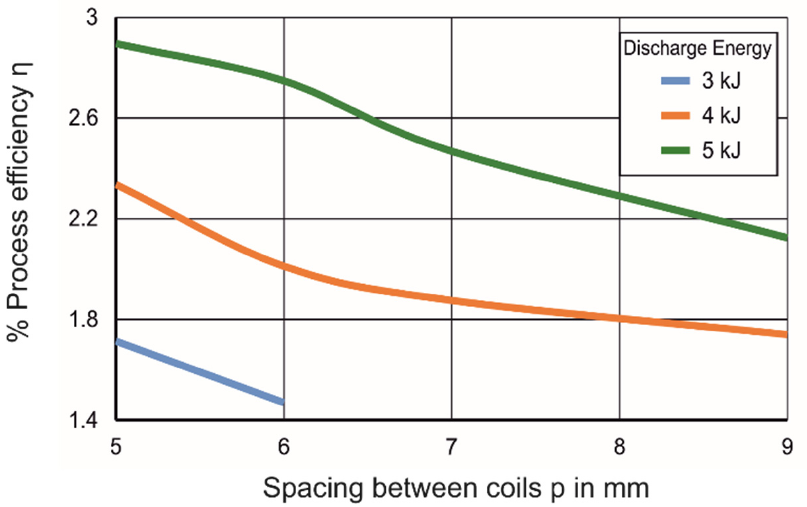
Figure 18. Reduction in process efficiency for various values of coil spacings. The overall process efficiency increases as the discharge energy increases.